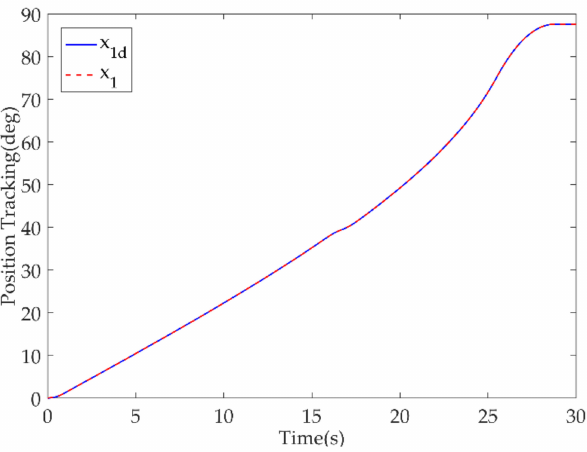
Figure 15. Tracking performance under RISE-NN-TAS controller in case 2.